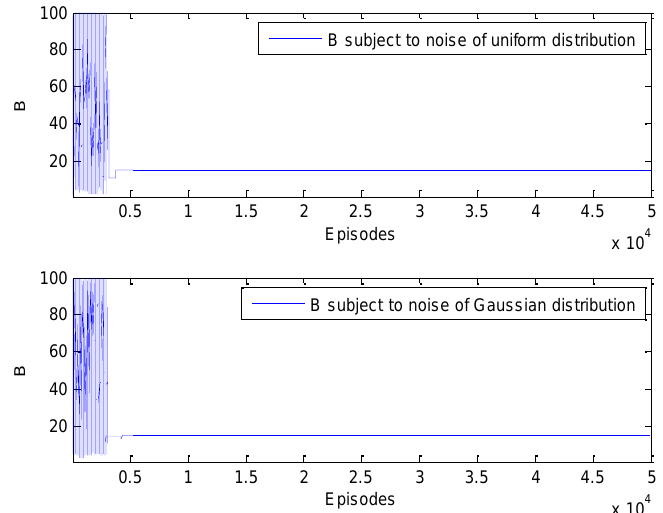
Figure 8. The episode training process with leakage of 0.01 ( B r = 20).